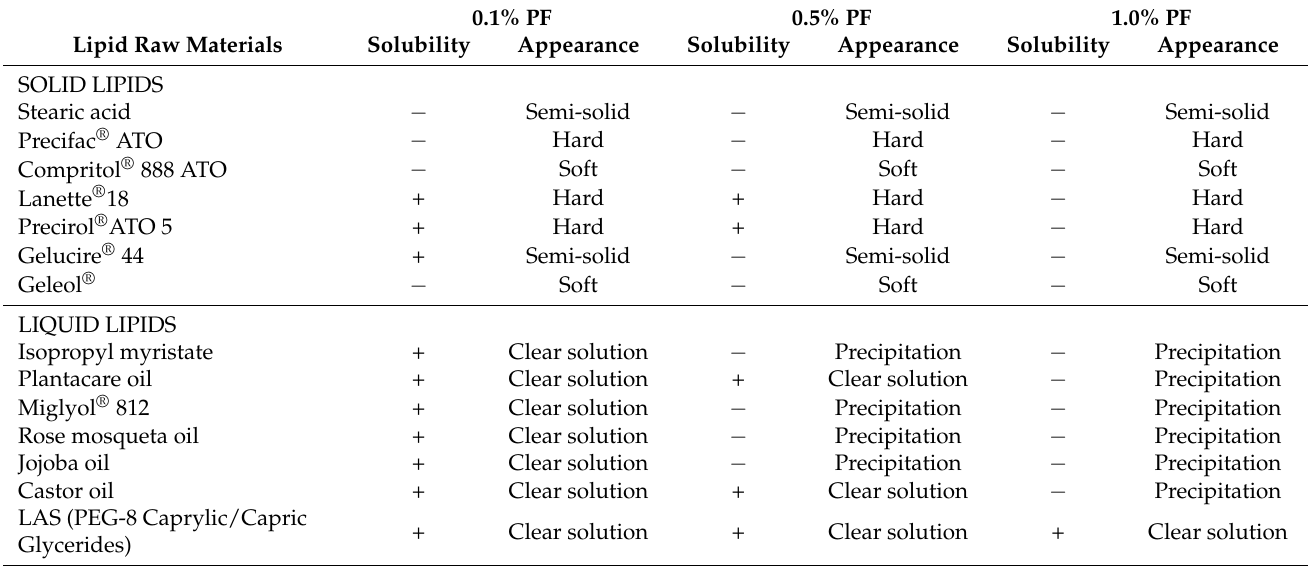
Table 1. Solubility of pranoprofen in different solid lipids and liquid lipids.